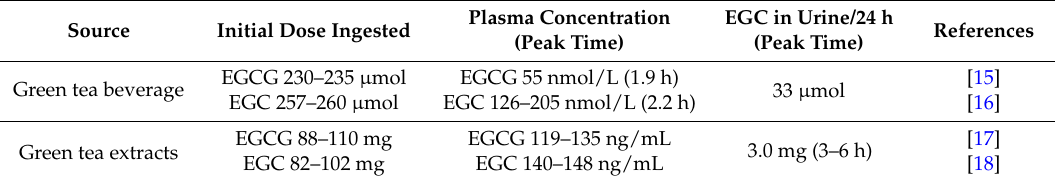
Table 1. Green tea catechin bioavailability studies